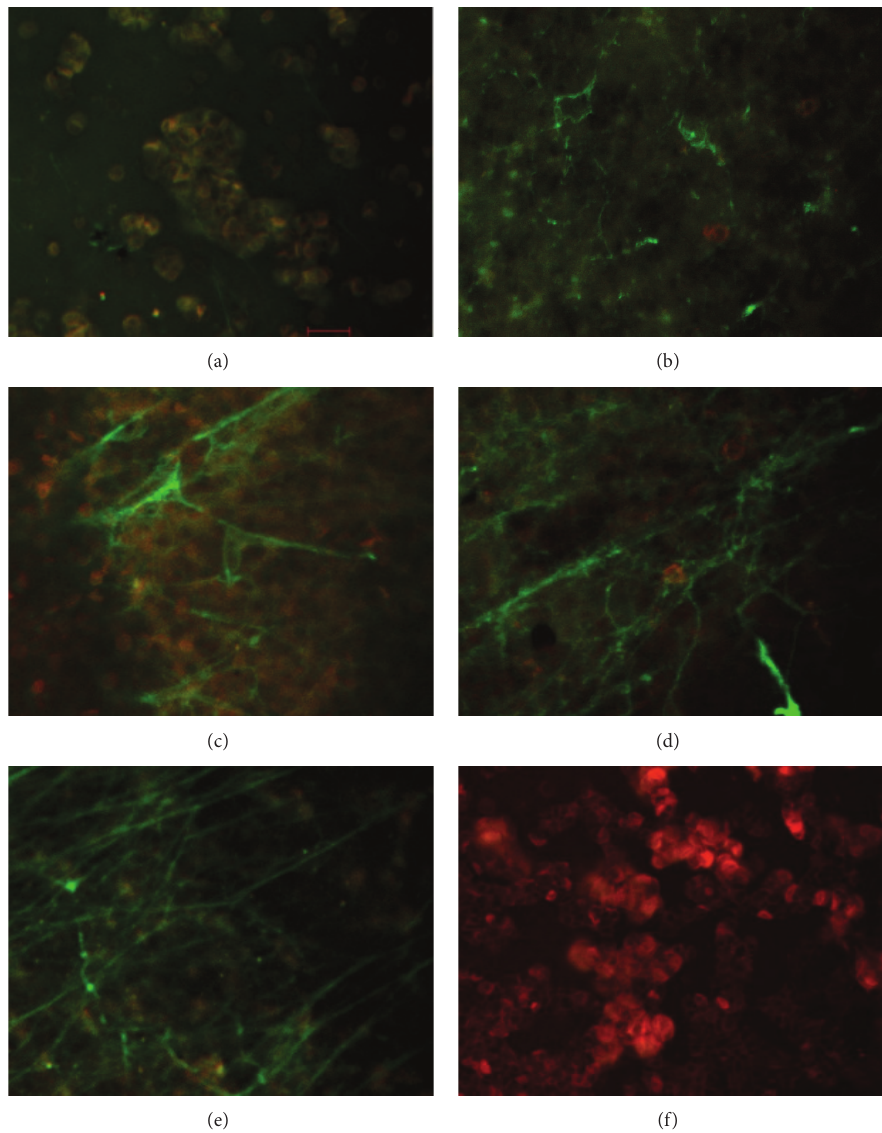
Figure 6: Confocal images for retracted WB clot treated with SK. (a) showed image of normal retracted WB clot. (b), (c), (d), (e) and (f) showed retracted WB clot treated with 5 IU/mL, 30 IU/mL, 50 IU/mL, 100IU/mL, and 1500,000 IU (stock) of SK concentrations after 1-hour incubation, respectively. (a) demonstrates fibrin integrated with RBCs in retracted WB clot (control untreated). (b) shows 5IU/mL concentration of SK where the fibrin started to separate from the RBCs. (c) depicts 30 IU/mL concentration of SK showing the fibrin that separated from the RBCs and a gradual thinning of fibrin fibres. (d) shows 50 IU/mL concentration of SK demonstrating fibrin separation from the RBCs and the fibrin fibres became much thinner and increased branching than 30IU/mL. (e) shows 100IU/mL concentration of SK where the fibrin almost separated from the RBCs and fibrin fibres became much thinner and increased branching than the 50 IU/mL SK. (f) shows 1500,000 IU (stock) of SK showing complete disappearance of fibrin from the